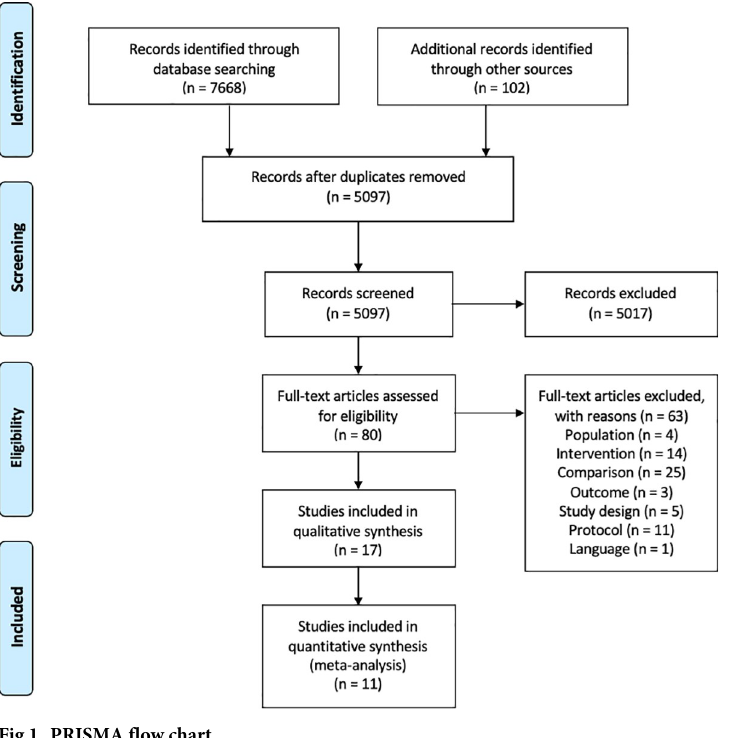
Fig 1. PRISMA flow